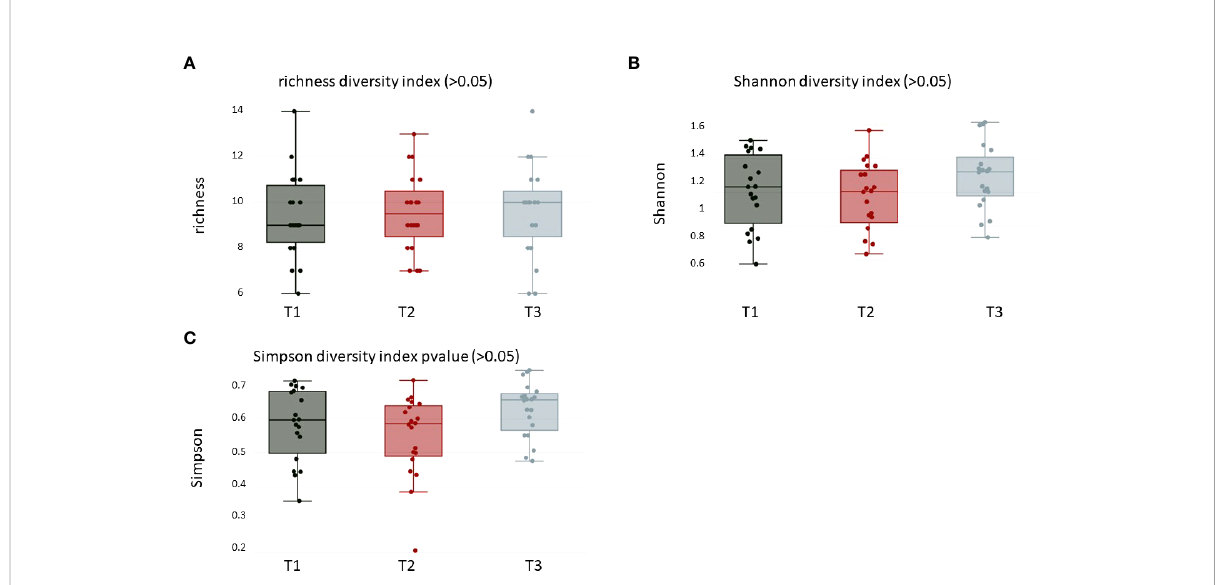
FIGURE 1 Alpha diversity calculations over all groups of (A) richness (pvalue > 0.05), (B) Shannon (pvalue > 0.05), and (C) Simpson (pvalue > 0.05) diversity index at the phylum level. T1: before/at start of chemotherapy, T2: 12 weeks after the onset of chemotherapy, T3: 52 weeks after the onset of